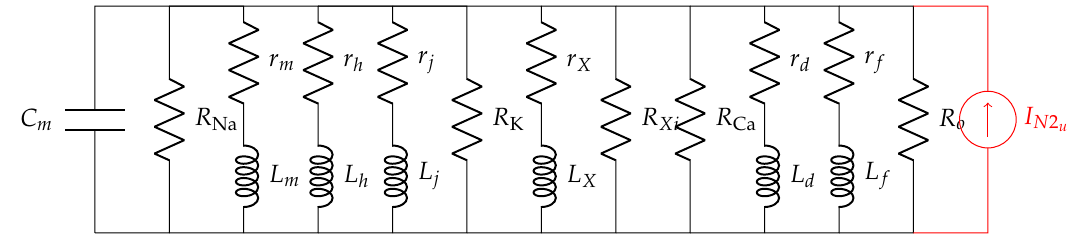
Figure 5. The linearized noisy membrane